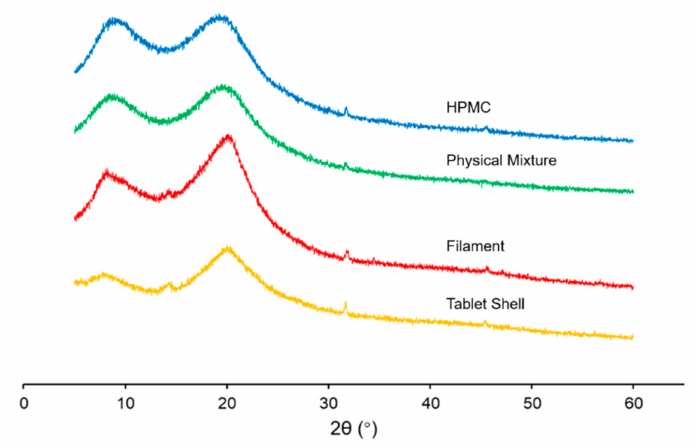
Figure 8. XRD results of HPMC, physical mixture, filament and 3D-printed shell of the tablet.